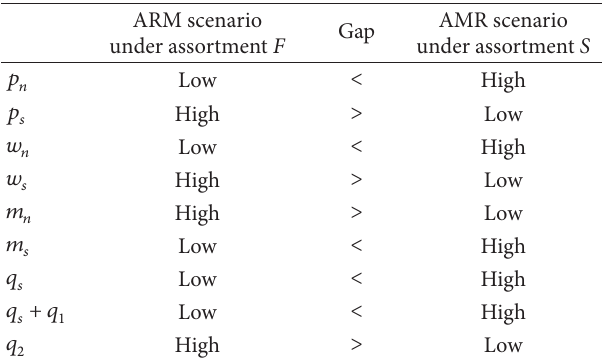
Table 4: Comparison between the ARM scenario under assortment F and the AMR scenario under assortment S, if 𝛽 is